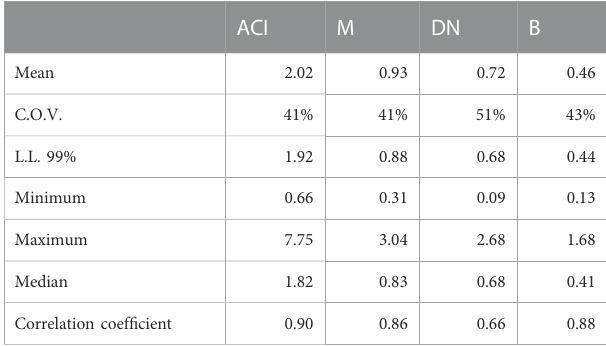
TABLE 3 Statistical measures for SR.